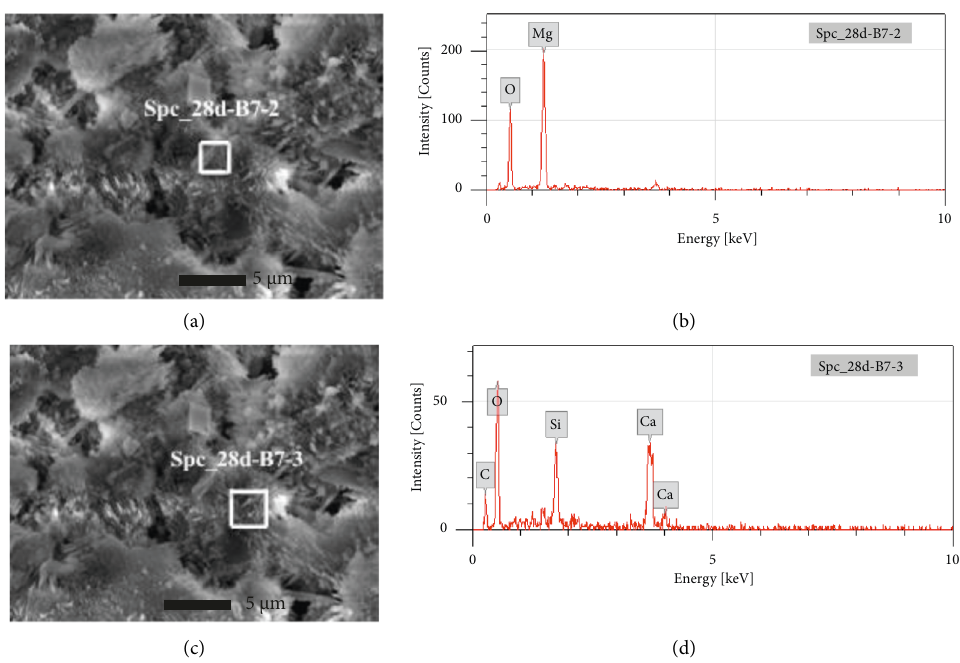
Figure 6: SSP-cement hydration microscopic morphology and energy spectrum analysis with the age of 28d: (a) hydration microstructure with age of 28d, (b) energy spectrum analysis of area Spc_28d_B7-2, (c) hydration microstructure with age of 28 d, and (d) energy spectrum analysis of area Spc_28d_B7-3.